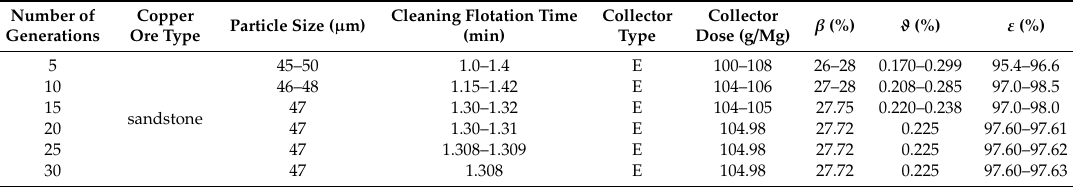
Table 10. A summary of the results of the copper ore flotation process optimisation in the Denver flotation machine taking the gradual development of the algorithm into account (E—aqueous solution of ethyl sodium xanthate).